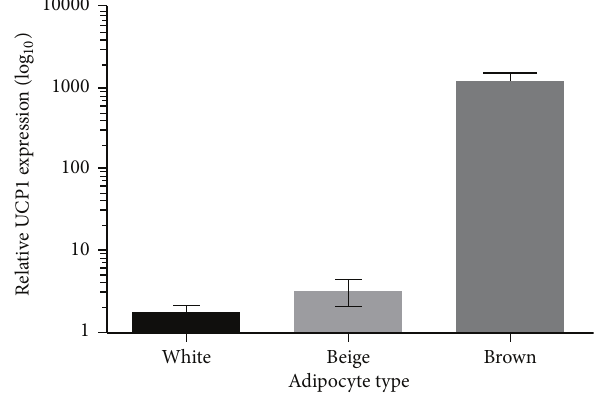
Figure 2: Summary of the differences in relative gene expression for uncoupling protein (UCP) 1 between white subcutaneous adipose tissue and either beige or brown depot of supraclavicular adipose tissue, classified according to low (i.e., < 10) or high (i.e., > 100) relative UCP1 gene expression. Adapted from Virtanen et al.